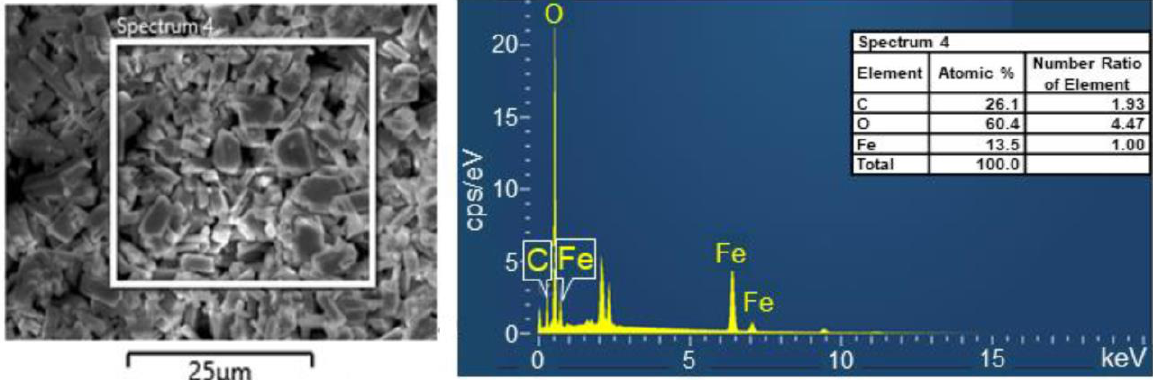
Figure 4. EDS analysis result of the precipitate sample. The ferrous ammonium sulfate concentration, the oxalic acid concentration, and the reaction temperature were 30 mmol·L⁻ 1 , 60 mmol·L⁻ 1 , and 25 °C, respectively.